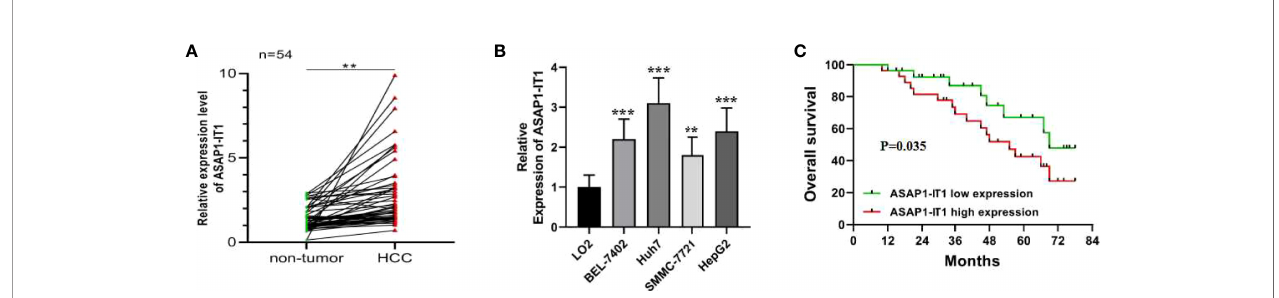
FIGURE 1 | Dysregulation of ASAP1-IT1 in hepatocellular carcinoma (HCC) and its correlation with prognostic factors in HCC patients. (A) ASAP1-IT1 expression levels in HCC and matched adjacent normal liver tissues. Quantitative reverse transcription polymerase chain reaction (qRT-PCR) analysis revealed that ASAP1-IT1 expression was signi fi cantly elevated in HCC tissues versus control specimens (**p < 0.01). (B) ASAP1-IT1 expression levels in HCC cells and normal liver cells. qRT- PCR analysis revealed that ASAP1-IT1 expression levels were signi fi cantly higher in the four HCC cell lines, including HepG2, Huh7, SMMC-7721, and BEL-7402, compared with the normal liver cell line, LO2 (**p < 0.01, ***p < 0.001 vs LO2). (C) Kaplan-Meier survival analysis of correlation between ASAP1-IT1 expression and overall survival (OS) in HCC patients. Data were expressed as mean ± standard